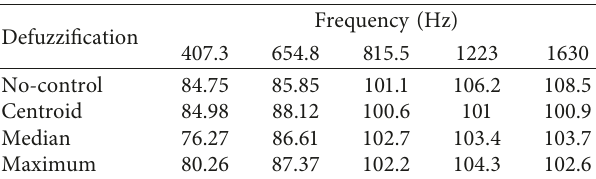
Table 4: The amplitudes of the system at the main frequency based on different solution fuzzy methods.